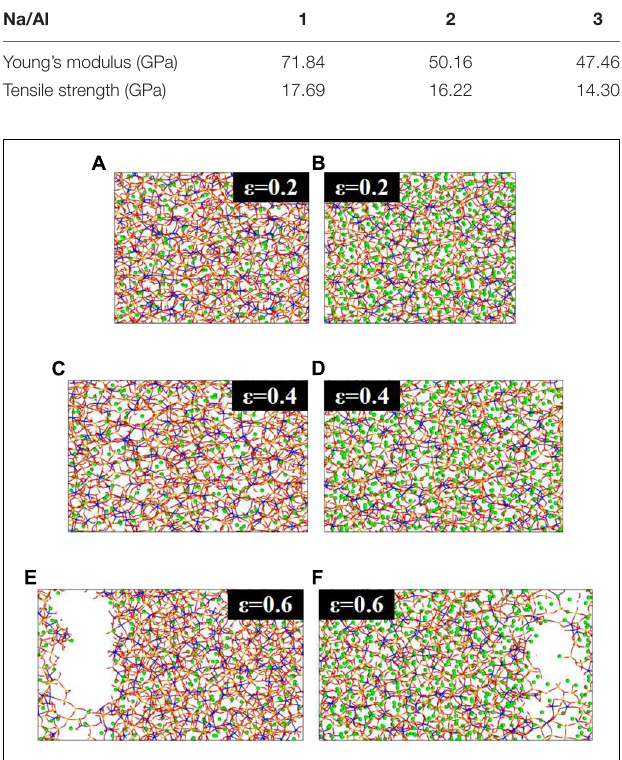
FIGURE 5 | Evolution of the structure during the tensile process with a Na/Al ratio of 1 and 3. From top to bottom, the strain state is 0.2 (A,B) , 0.4 (C,D) , and 0.6 (E,F) Å/Å,